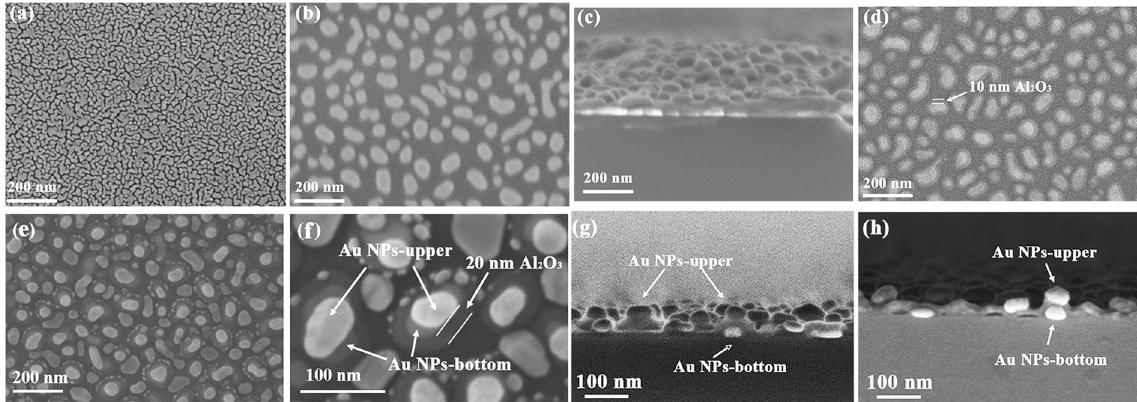
Figure 4. FE-SEM images of ( a ) as-deposited Au film, ( b ) surface and ( c ) cross-section of Au NPs, ( d ) 10 nm Al